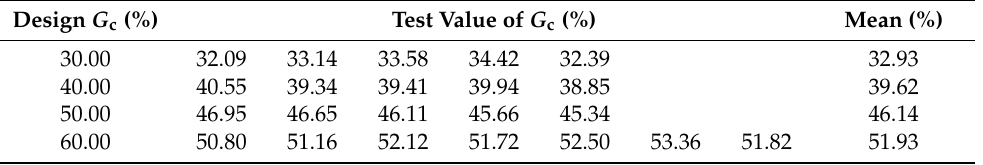
where M i and M f are, respectively, the weights of the specimen before and after calci- nation (g); ρ f is the density of the glass fiber (g/cm 3 ); and ρ r is the density of the resin matrix (g/cm 3 ). Table 3. G c values of the single-material specimens determined by burn-off tests. Design G c